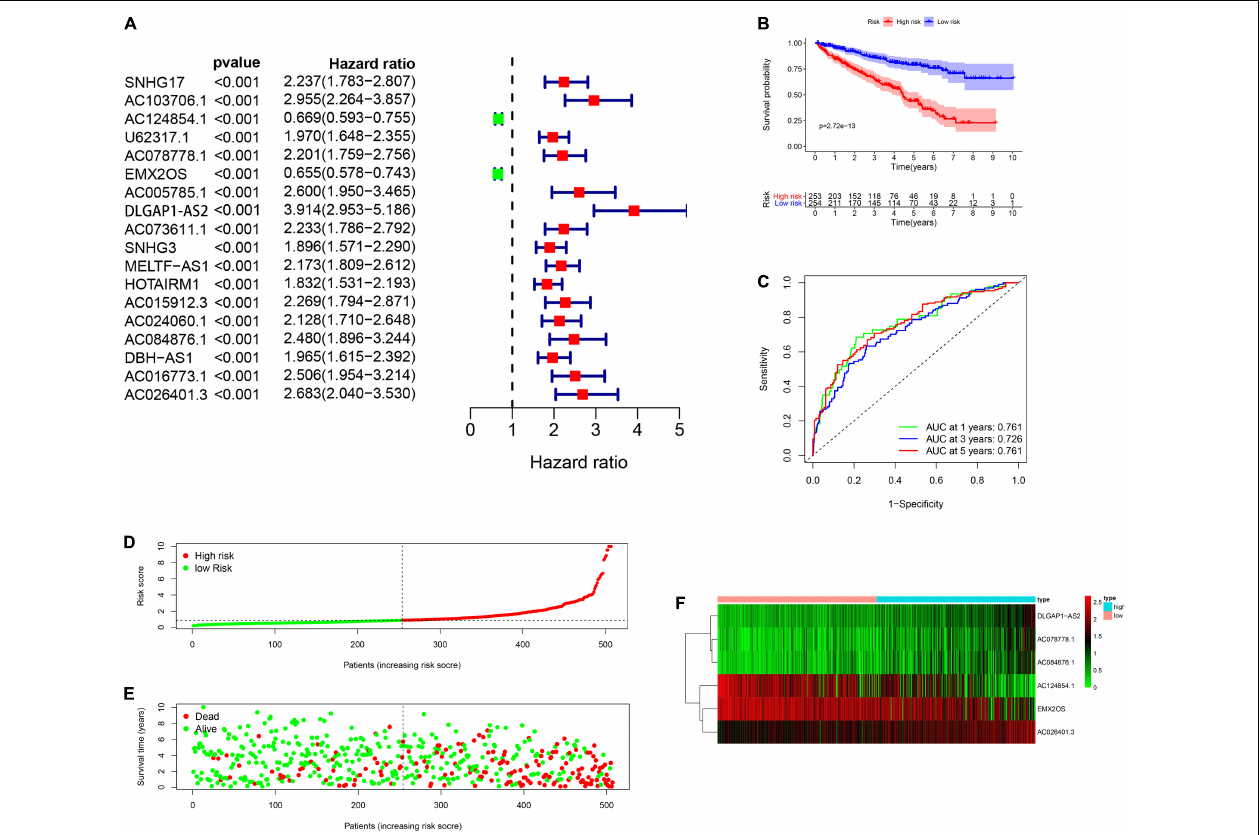
FIGURE 1 | Construction and verification of glycolysis-related lncRNAs prognostic signatures in RCC patients. (A) The univariate Cox regression analysis combining the clinical surviving statistics exhibit that expression of 18 lncRNAs significantly correlated with OS of RCC patients. (B) Kaplan-Meier survival curve analysis shows that the significantly different survival time between the low-risk and the high-risk group. (C) ROC curve indicate the reliability of applying the risk score to predict the prognosis of RCC patients. (D) Distribution of high-risk and low-risk patients with renal cell carcinoma based on the glycolysis-related lncRNAs prognosis signature. (E) The scatter dot plot shows that the relationship between survival rates of the RCC patients and the risk score. (F) The heatmap shows the different expression of prognostic signature-related lncRNAs in different risk groups.